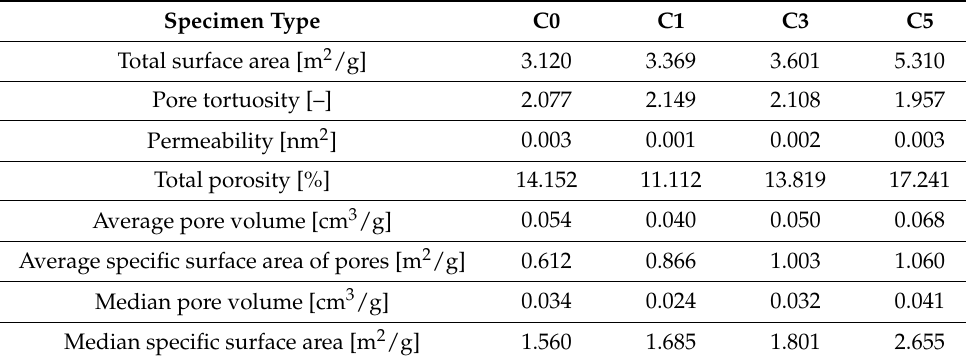
Table 5. The basic properties of the tested concrete obtained by MIP.